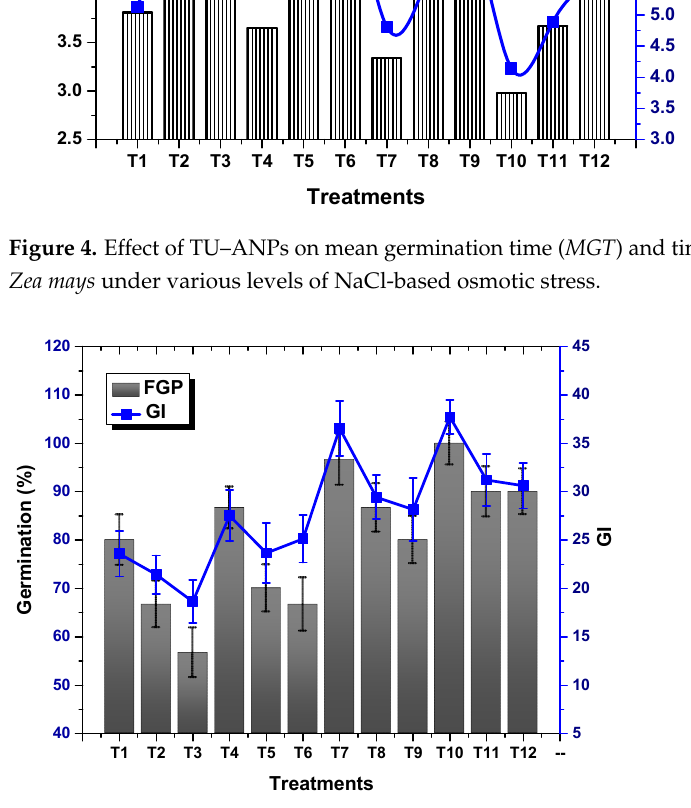
Figure 5. Effect of TU–ANPs on germination index ( GI ) and germination percentage ( GP ) of Zea mays under various levels of NaCl-based osmotic stress.